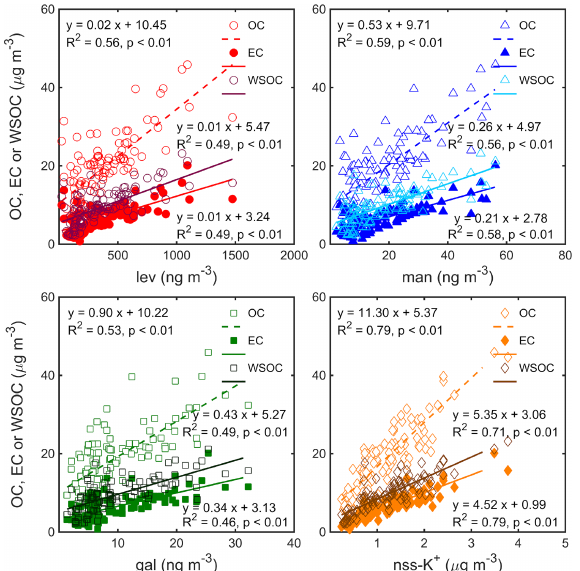
Figure 4. Correlations of OC, EC and WSOC vs. levoglucosan (lev), mannosan (man), galactosan (gal) and non-sea-salt potassium (nss-K + ) in PM 2 . 5 from 14 to 29 January 2015 in Nanjing.